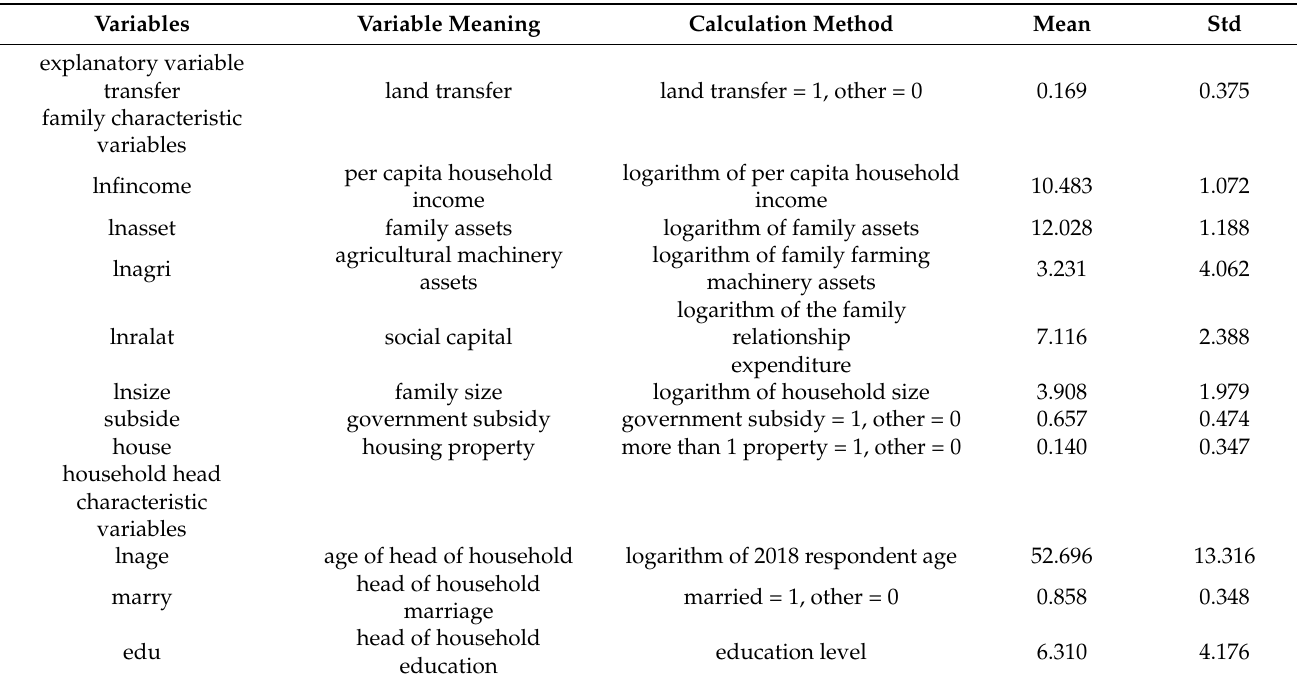
Table 1. Variable definition and descriptive